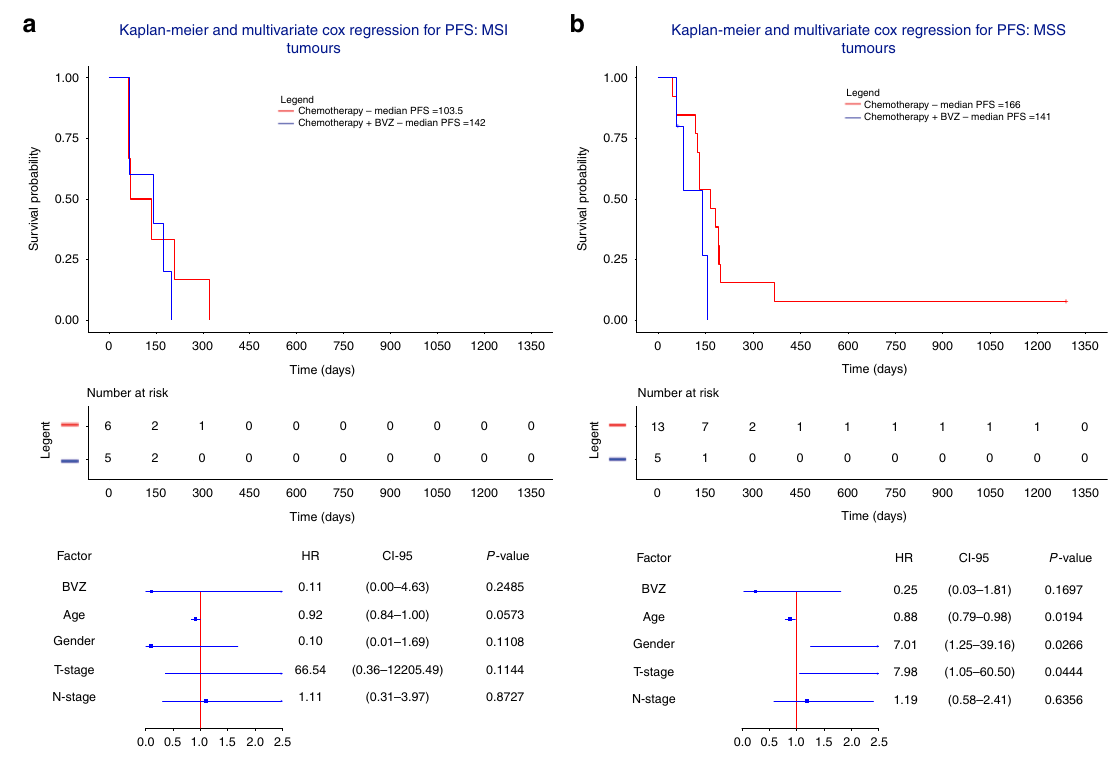
Fig. 5 Multivariate Cox regression in microsatellite-instable ( n = 11) or -stable ( n = 18) cluster 1 tumors. a , b Kaplan-Meier plots and multivariate Cox regression with hazard ratios, 95% con fi dence intervals and P-values are shown while correcting for the relevant covariates in CNA cluster 1 tumors receiving chemotherapy + BVZ strati fi ed for tumors that were either MSI-positive ( n = 11) ( a ) or MSI-stable ( n = 18) ( b ). In none of the two groups